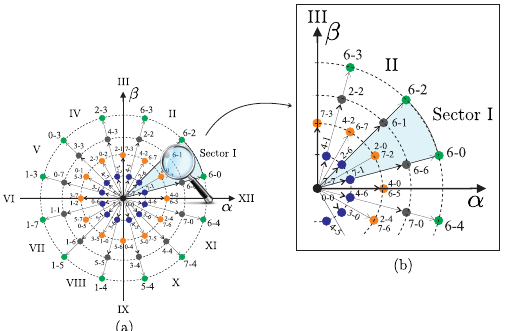
Figure 4. Considered sectors for the six-phase VSI in the ( α - β ) frame: ( a ) Available vectors; ( b ) A selected specific sector shown as zoom.